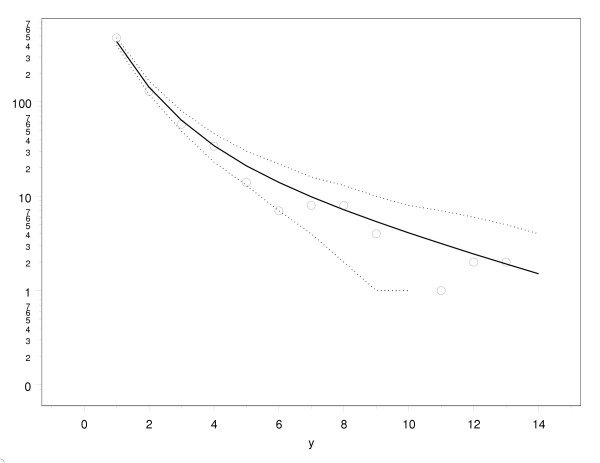
Frequencies of SAGE counts (restricted to genes mapped to a single tag) in IDC-3, given that the same tag had count zero in HTM library 145. Compared to the expected frequencies and 95% confidence bounds from the bivariate model, restricted to tags with counts lower than 15 in both libraries.